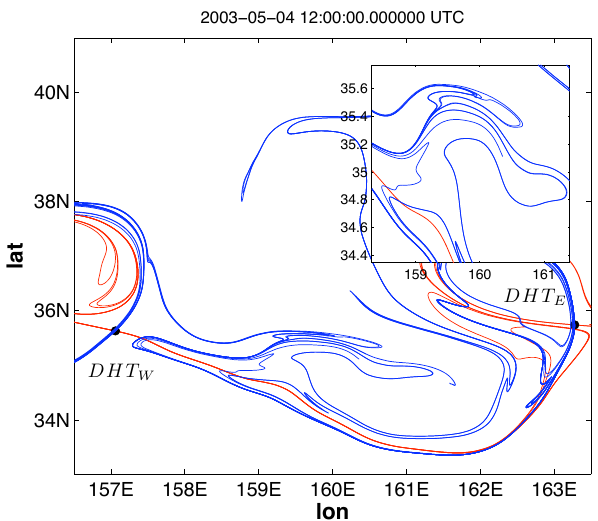
Fig. 5. Stable (blue) manifold of DHT E at the eastern end of the current and unstable (red) manifold of DHT W at the west.